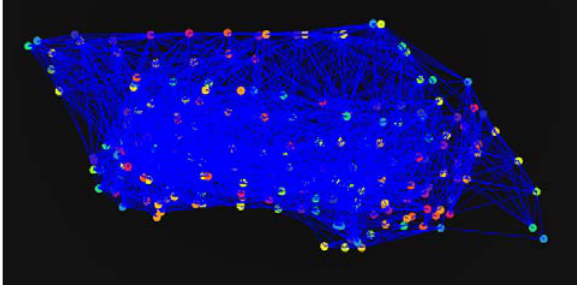
Figure 6. How the Global Optimization between local maps is shown in the post processing